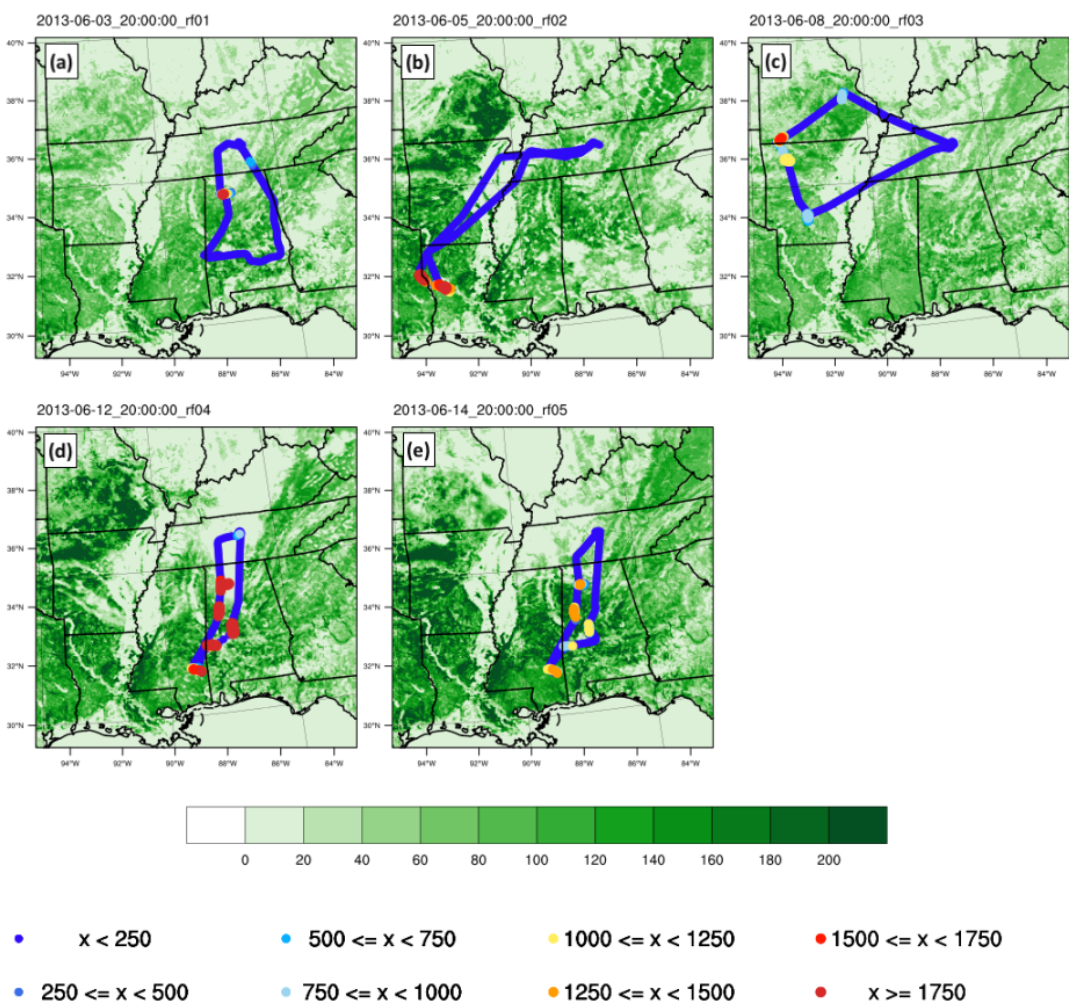
Figure 3. The x values (i.e., colored dots) denote the isoprene mixing ratios (pptv) along the aircraft flight tracks plotted over the different maps of isoprene emission factors (molkm − 2 h − 1 ) from the M2.04 simulation. Results are for each research flight day at 15:00 local time (20:00UTC), namely (a) rf01 on 3 June 2013, (b) rf02 on 5 June 2013, (c) rf03 on 8 June 2013, (d) rf04 on 12 June 2013, and (e) rf05 on 14 June